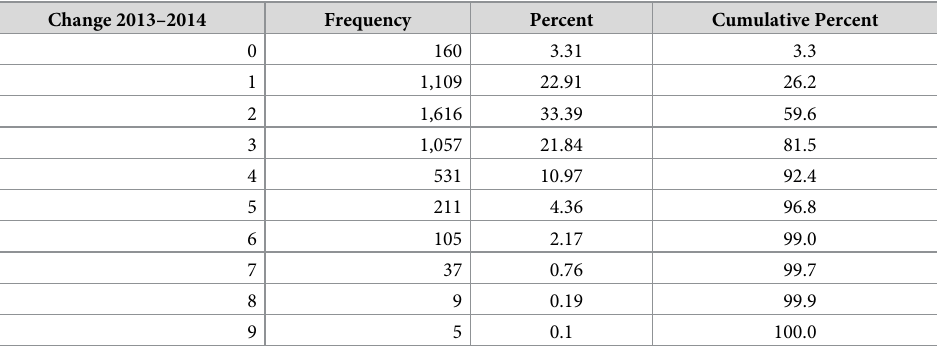
Table 6. Provider change between 2013 and 2014 for suppressed